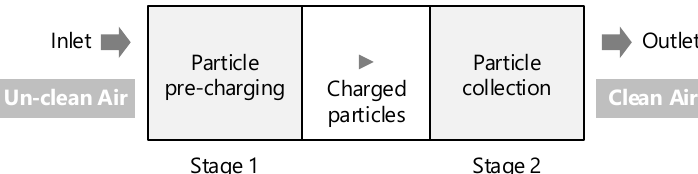
Figure 8. Schematic of a two-stage ESS.